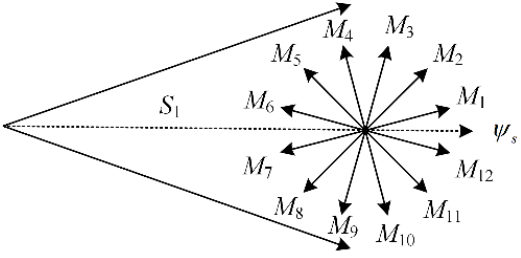
Figure 12. Selection of space voltage vector in sector 1.